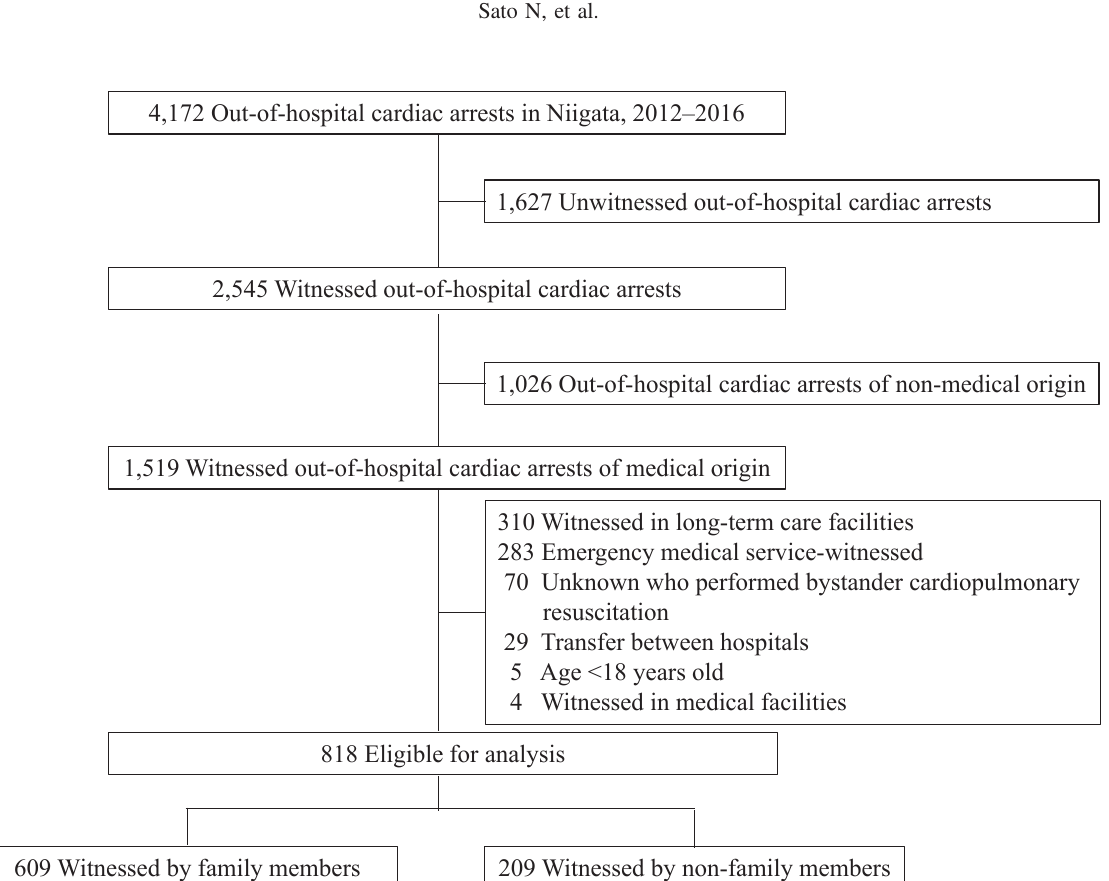
Table 1. Patient characteristics witnessed by a person Witnessed by family Witnessed by non-family members n = 609 % n = 209 % Age, years, median